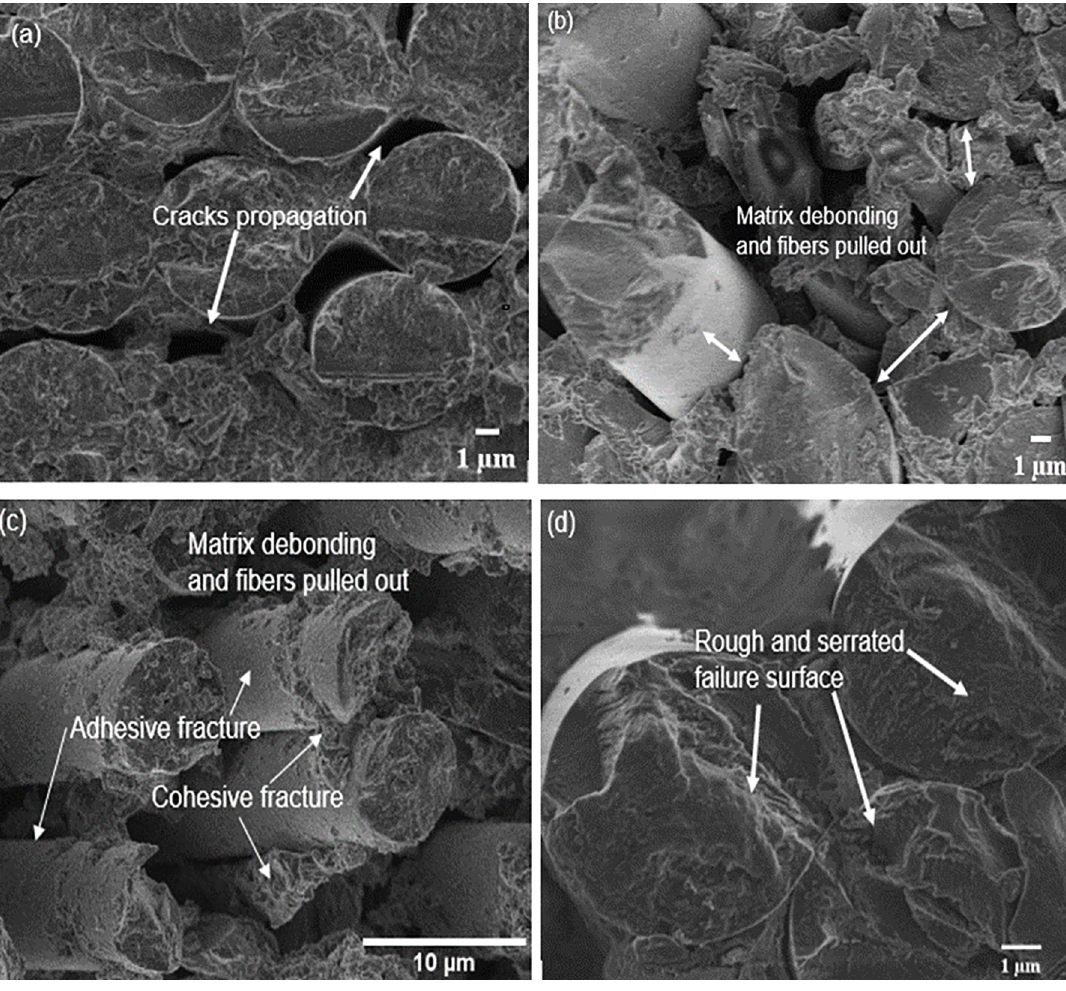
Figure 6. SEM image of carbon fiber failure